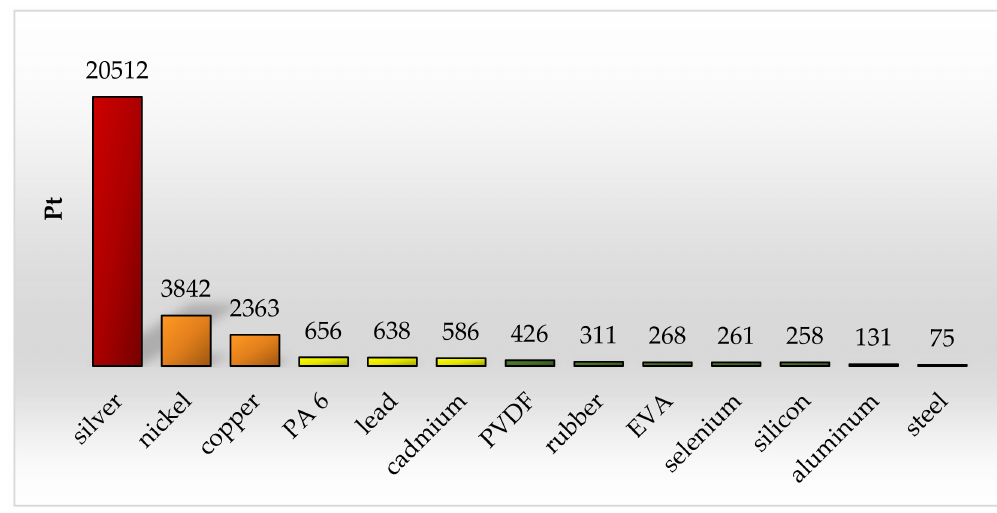
Figure 8. Results of grouping and weighting the environmental consequences of 1,000 kg of selected plastics and materials included in photovoltaic elements for all categories of influence [unit: